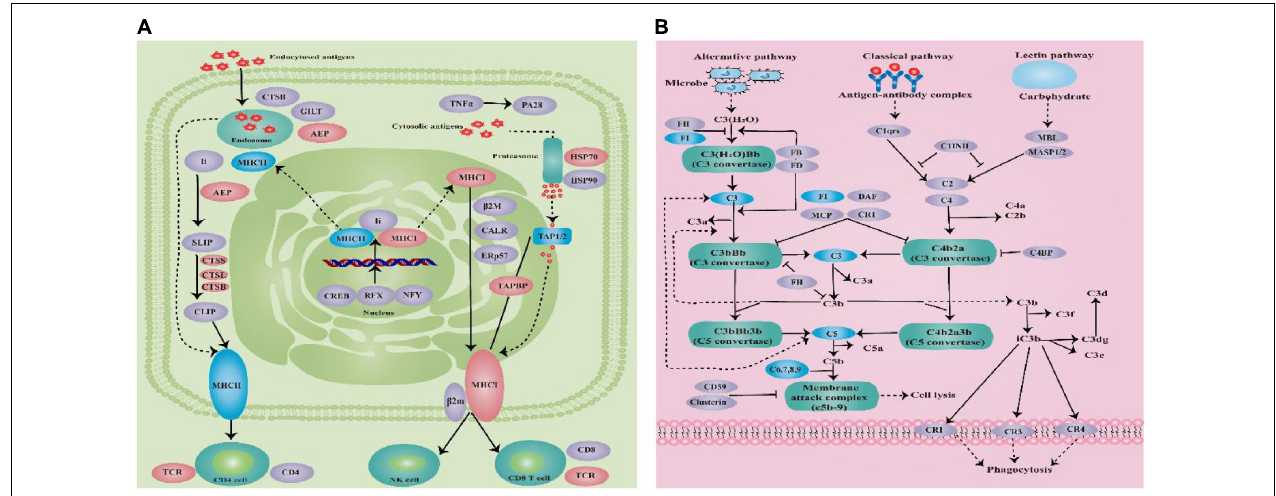
FIGURE 9 | (A) Schematic diagram of antigen processing and presentation pathway. (B) Schematic diagram of complement and coagulation cascades pathway (blue indicates downregulation, red indicates upregulation, and purple indicates no significant